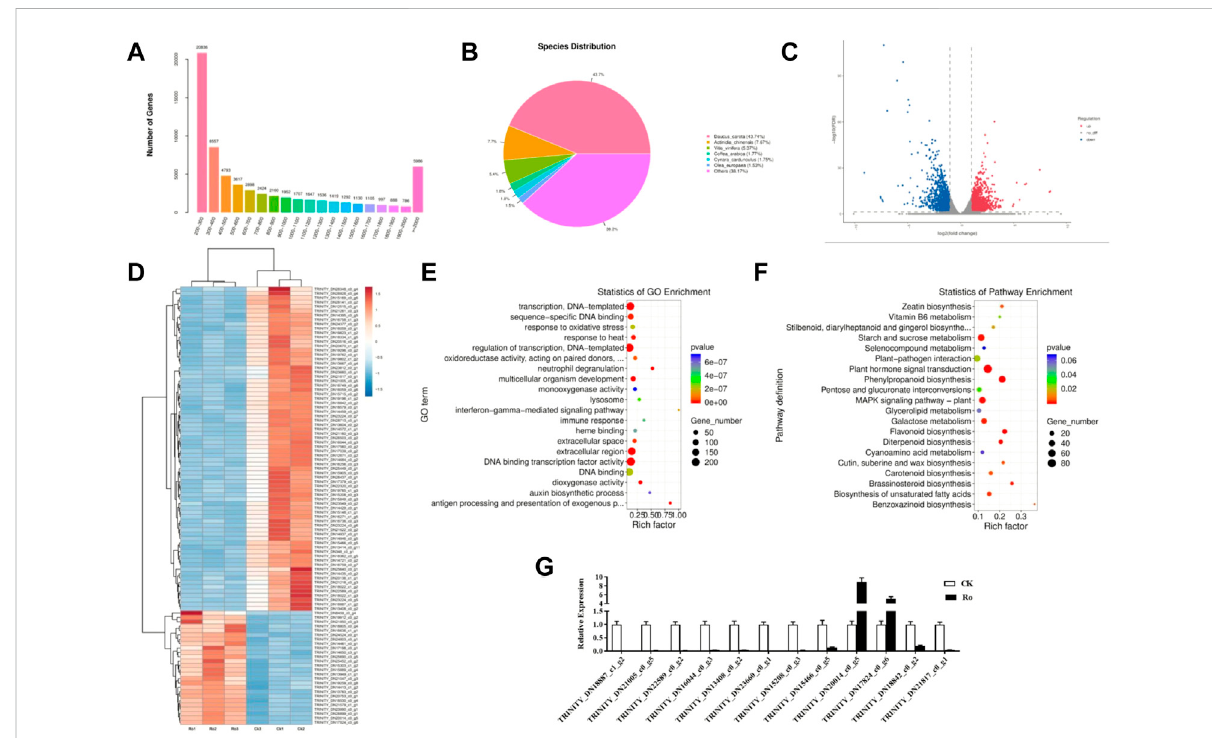
FIGURE 4 DifferentialmRNAanalysisresultsandvalidation.Distributionofunigenelengthsintheginsengcallustranscriptome; X ,lengthoftheunigene; Y , number of unigenes (A) . Non-redundant homologous species distribution (B) . Comparison of the differential genes between the Ro and CK treatments (C) . Hierarchical analysis of the differentially expressed genes (DEGs) (D) . GO enrichment analysis of the DEGs (E) . KEGG enrichment analysis of the DEGs (F) . Comparison of the RNA-seq and qPCR results (G)